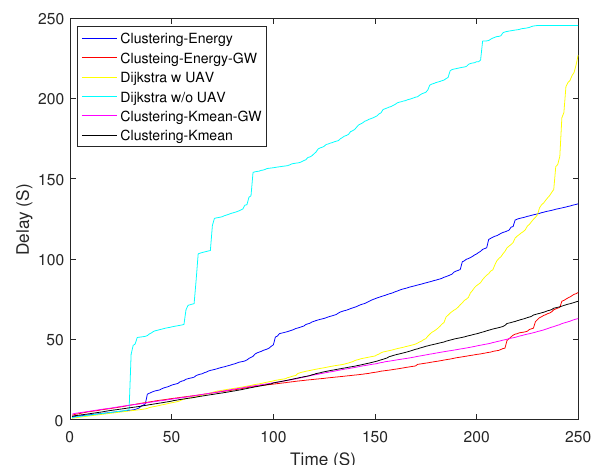
Figure 9. End-to-end delay.